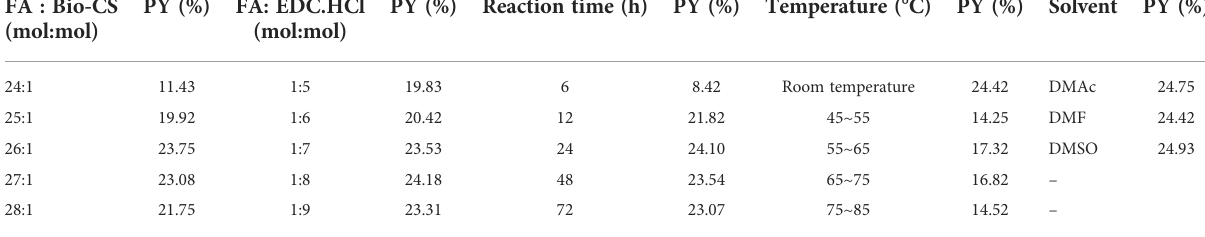
TABLE 1 Analysis of in fl uencing factors on FA-CS-Bio material